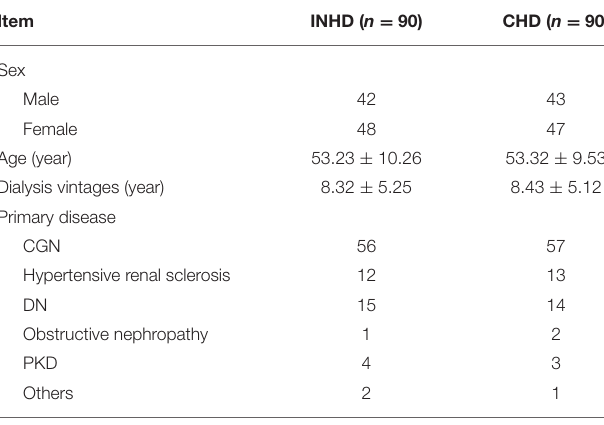
TABLE 1 | Baseline characteristics of patients undergoing hemodialysis after